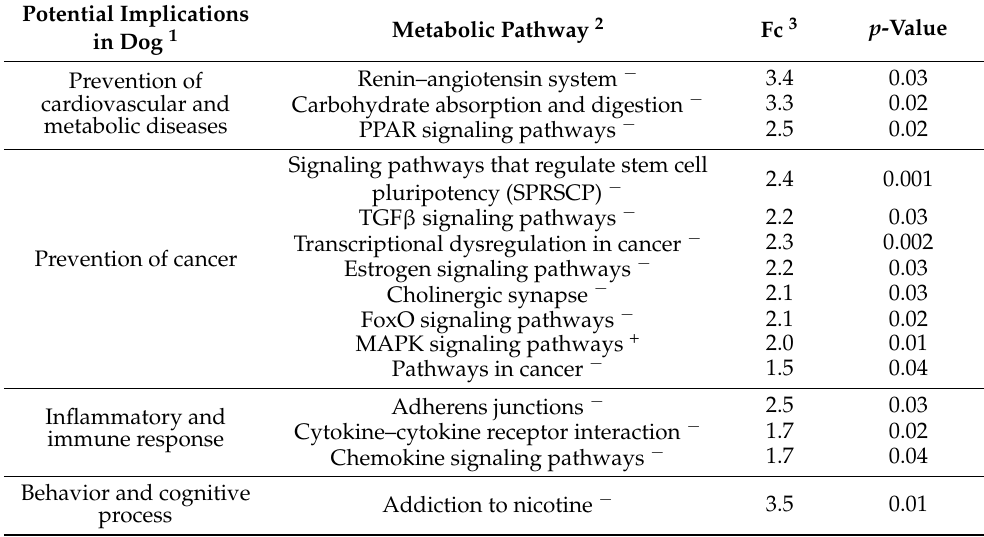
Table 4. Biological processes enriched by polyherbal when compared to choline chloride ∆ .